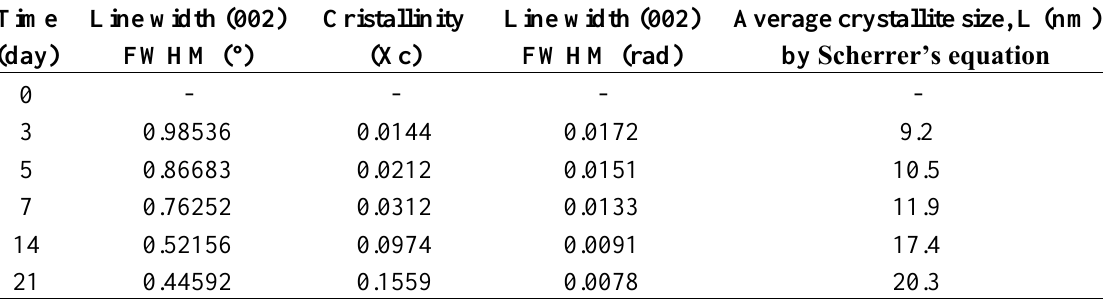
Table 1. The average crystallite sizes calculated by Scherrer’s